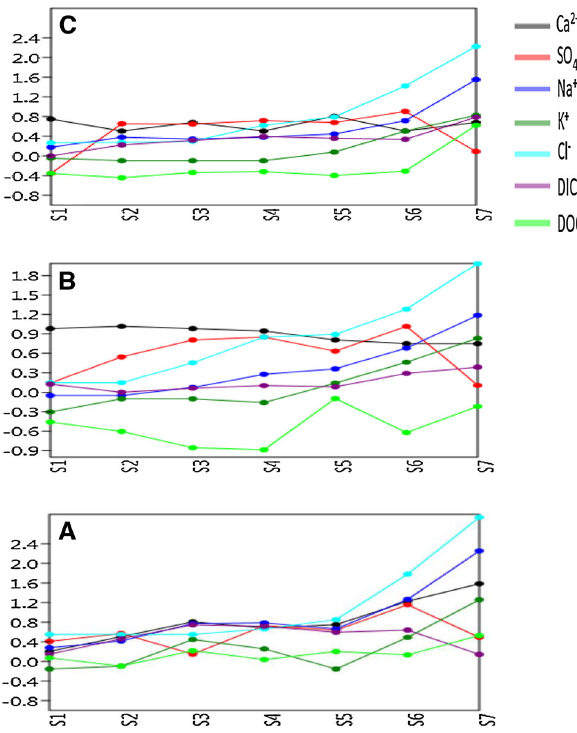
Fig. 2 Log-Y transformed data of ions at various stations during a PRM, b MON and c POM